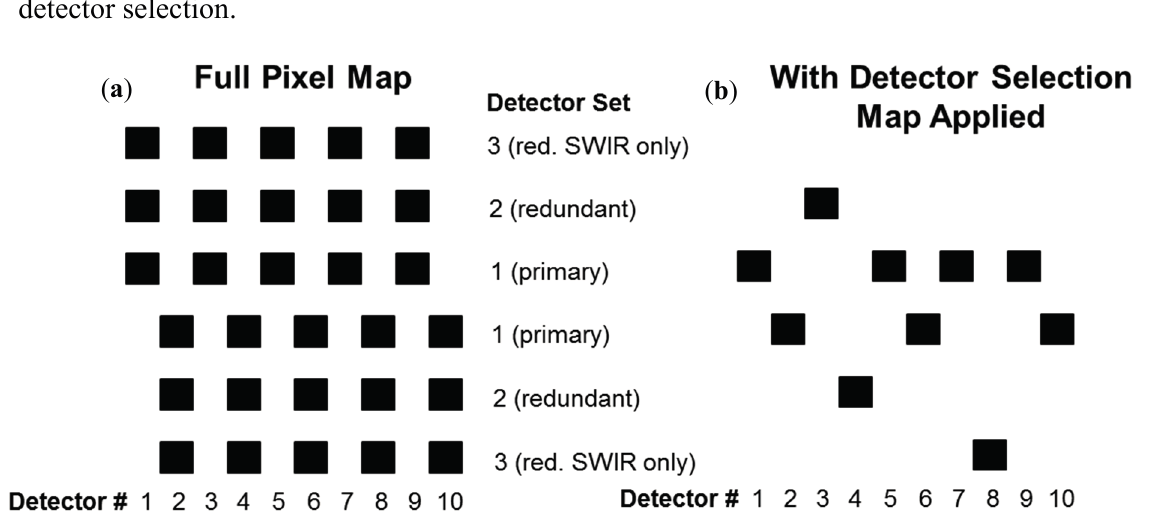
Figure 3. Left—schematic of the OLI detector pattern showing even/odd detector offset and redundant detector rows. Right—example of final active detector set after primary/redundant detector